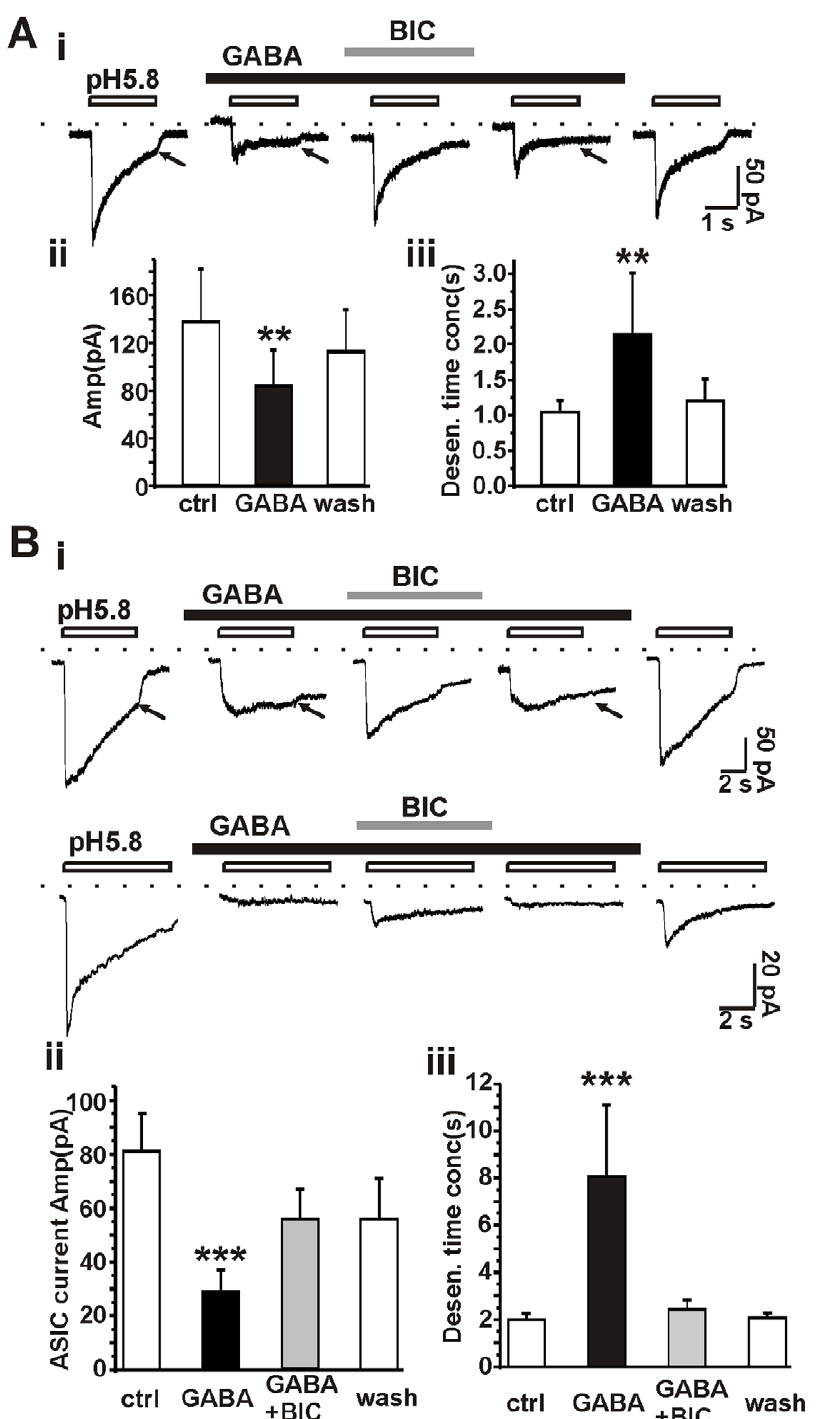
Figure 4. ASIC currents are modified by GABA in nucleated patches and outside-out patches excised from hippocampal neurons. A, ASIC currents recorded from nucleated patches. The peak ASIC current amplitude was 2 279 6 92 pA (n=16). i, representative traces of ASIC current recorded from nucleated patches. GABA (100 m M) attenuated ASIC currents and rendered ASIC currents desensitized slower and inactivated incompletely (denoted by arrows). Bar graph shows the statistics of peak current amplitude (ii) and desensitization time constant (iii) of ASIC currents in the absence or presence of GABA. n=9, **, p , 0.01, GABA group versus control group. B, ASIC currents recorded from outside-out patches. The peak ASIC current amplitude were 2 58 6 7 pA (n=36). i, two representative traces of ASIC currents recorded from outside-out patches. GABA (100 m M) attenuated the peak current amplitude and altered the current kinetics of ASICs. Arrows denote that the deactivation of ASIC currents was prolonged. Bar graph showing the summarized data of peak current amplitude (ii) and desensitization time constant (iii) of ASICcurrents in the absence or presence of GABA. Blocking GABA A receptors with bicuculline (100 m M) reversed the impact of GABA on ASICs. n=14, ***, p , 0.001, GABA group versus control group.